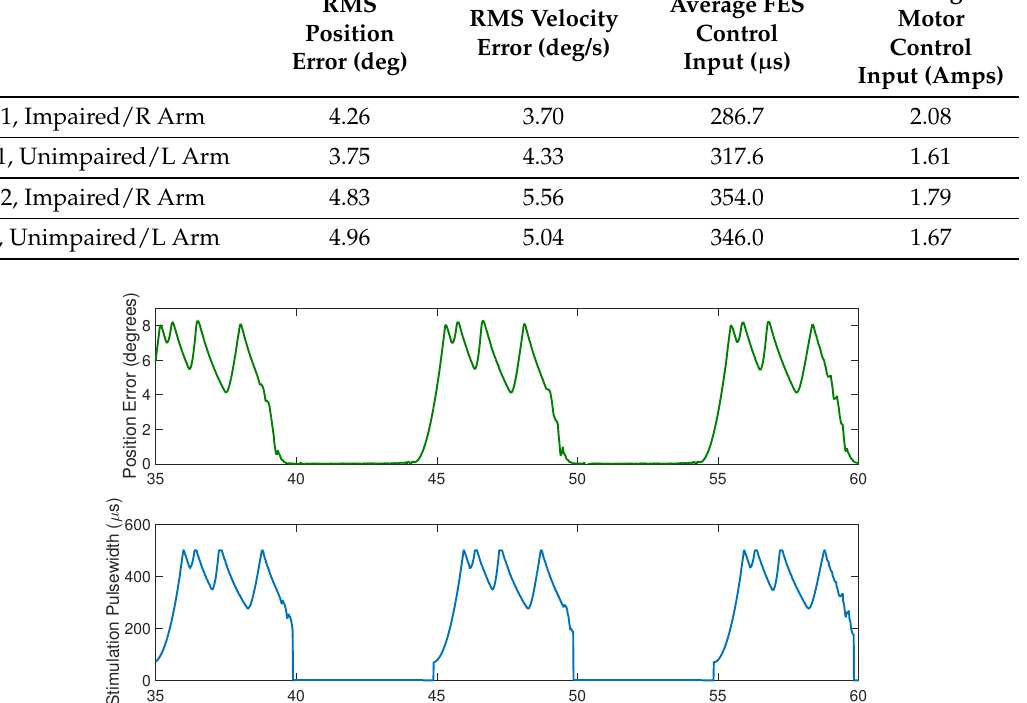
Figure 3. Position error and stimulation pulsewidth (i.e., FES input) for the right arm of Participant 2 during trials where the lower stimulation threshold iteratively decreased according to the constant ρ = 0.8. The zoomed view of biceps curls 4–6 is provided to easily compare the change in FES control input to the position